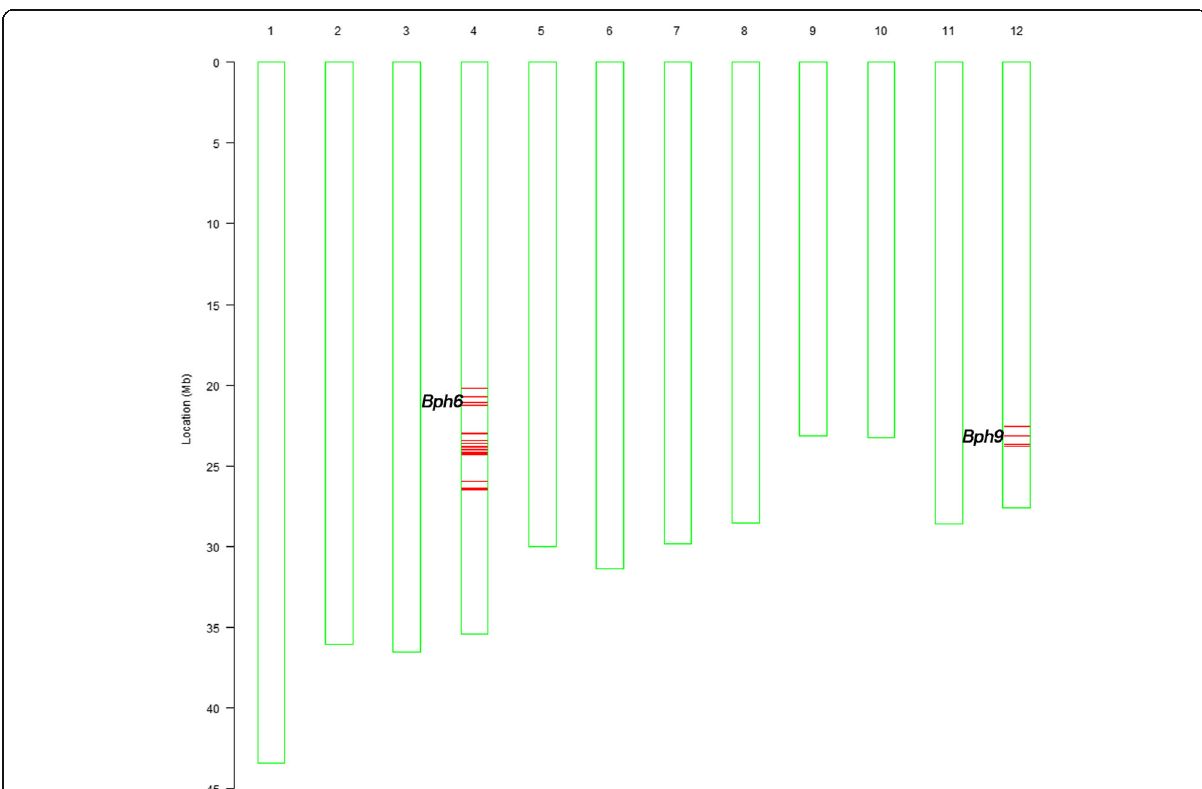
Fig. 1 Genetic background assay of LuoYang69 using the RICE6K array. The red lines on chromosome 4 and chromosome 12 indicate the SNP loci with homozygous genotypes where genomic fragments of the donor parent Swarnalata ( Bph6 ) and Pokkali ( Bph9 ) were introgressed,